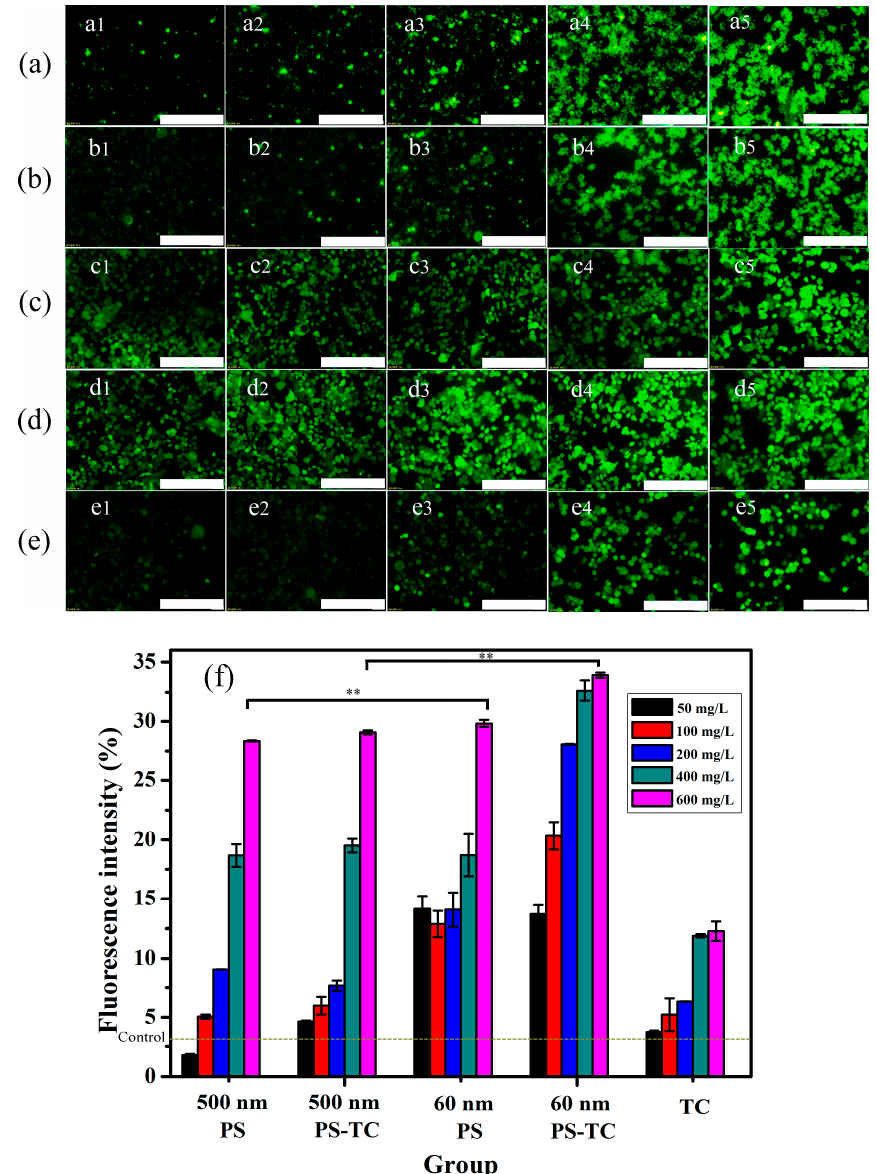
Figure 5. Fluorescence images and intensity of AGS cells. ( a ) Fluorescence images of exposing 500 nm PS-MPs (50, 100, 200, 400, 600 mg / L); ( b ) Fluorescence images of exposing 500 nm PS-TC MPs (50, 100, 200, 400, 600 mg / L); ( c ) Fluorescence images of exposing 60 nm PS-NPs (50, 100, 200, 400, 600 mg / L); ( d ) Fluorescence images of exposing 60 nm PS-TC NPs (50, 100, 200, 400, 600 mg / L); ( e ) Fluorescence images of exposing TC (0.5, 1, 5, 10, 20 mg / L); ( f ) Proportion of fluorescence intensity in Figure 5a–e; (scale: 250 µ m; **: p < 0.01).